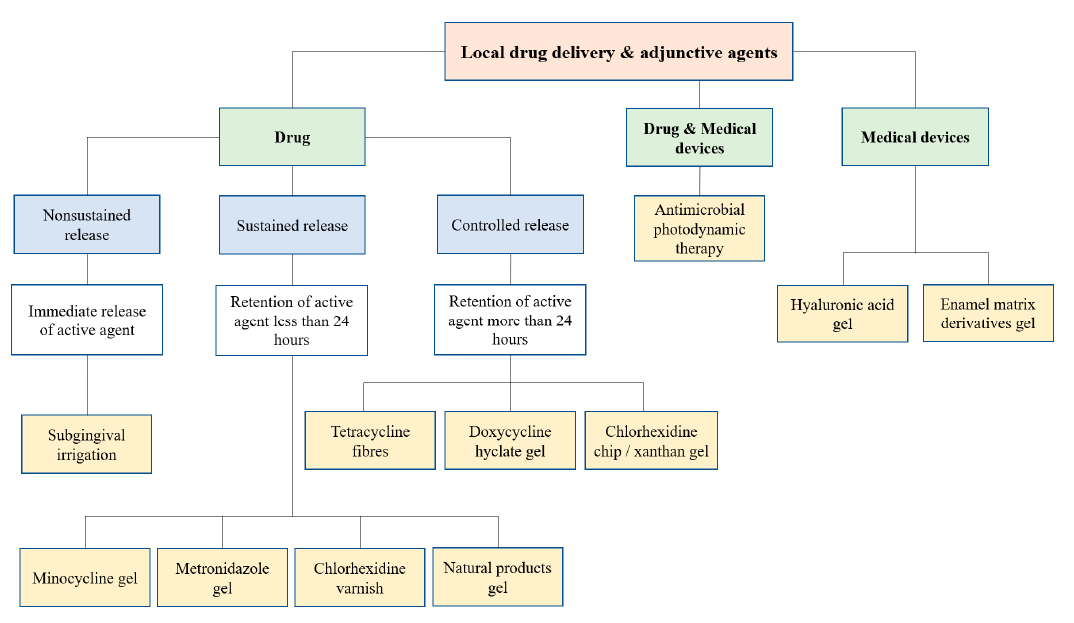
Figure 1. Classification of commercially available local drug delivery and adjunctive agents (LDA) for nonsurgical periodontal